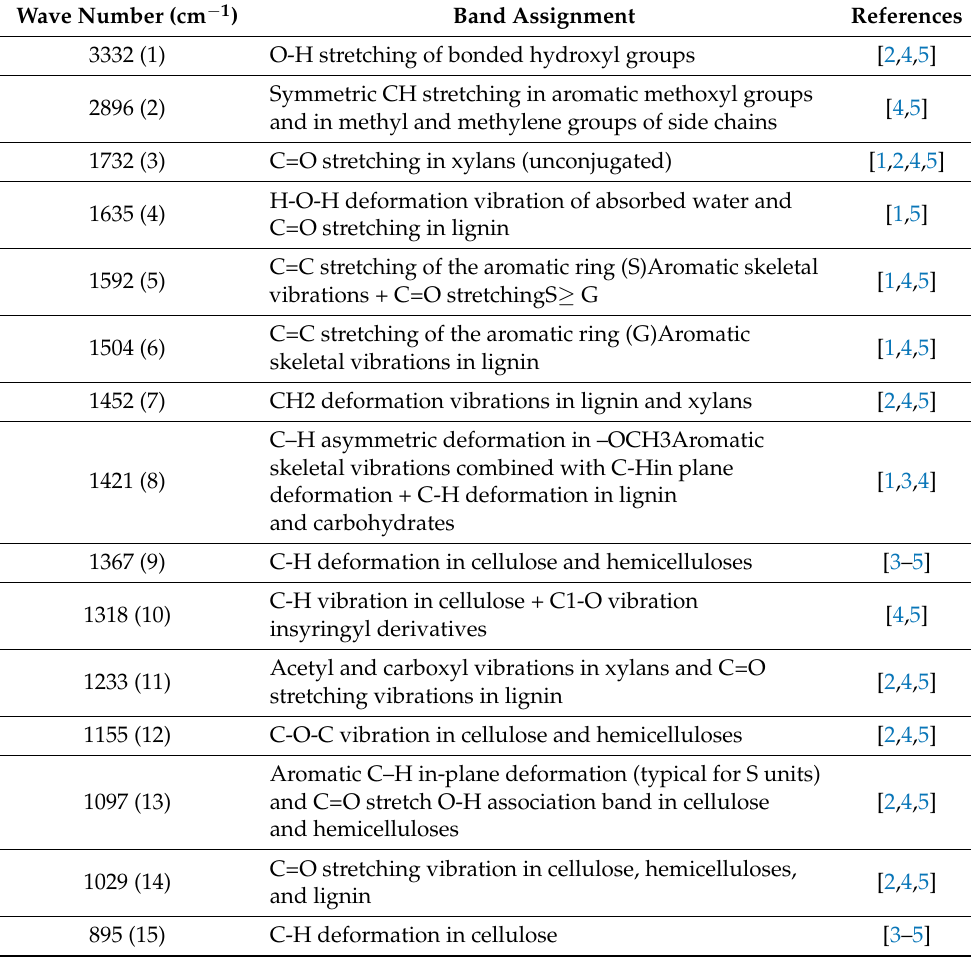
Table 3. Assignments of IR peaks to various cell wall polymer